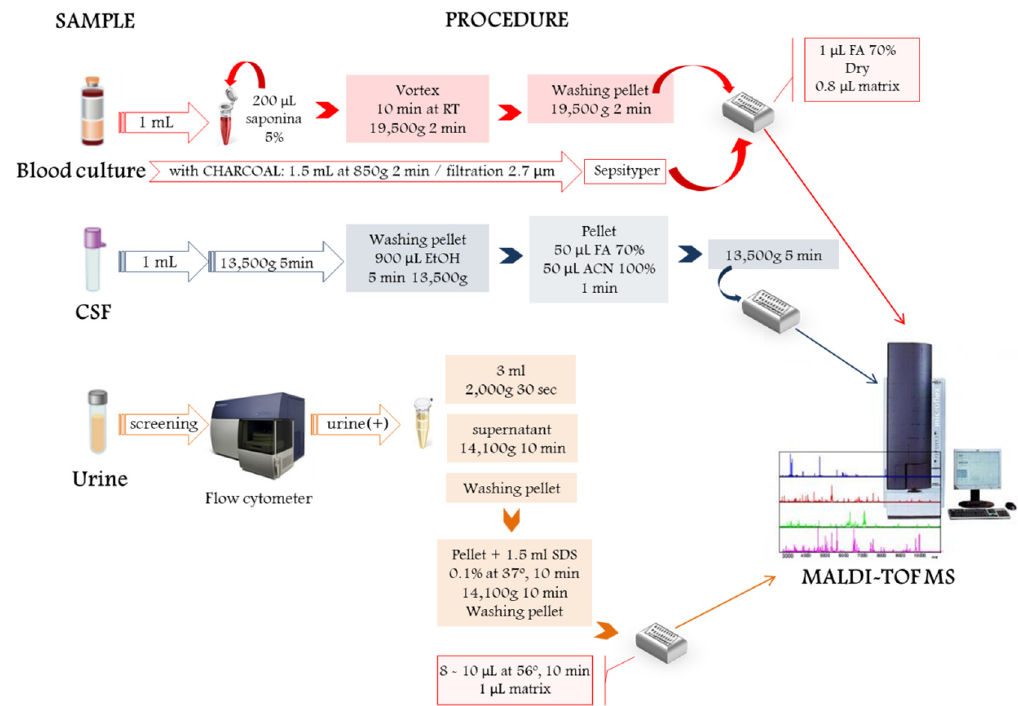
Figure 2. Hypothetical protein extraction workflow for direct microbiological diagnosis from biological samples from blood culture, cerebrospinal fluid (CSF) and urine.